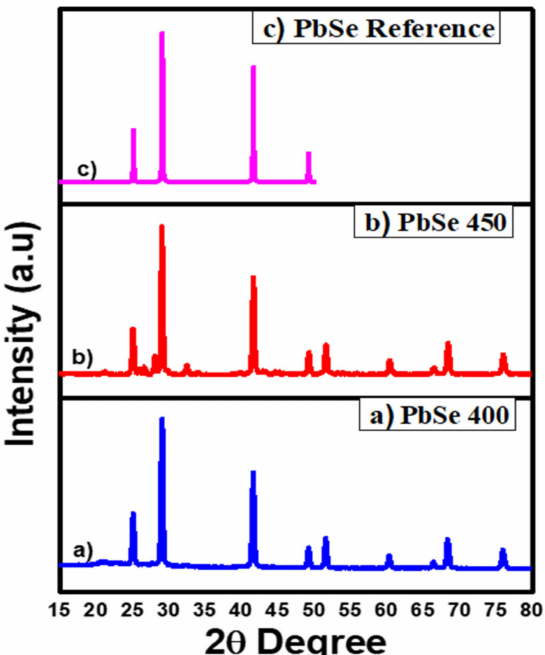
Figure 2. XRD pattern of PbSe prepared at ( a ) 400 ◦ C; ( b ) 450 ◦ C; ( c ) PBSe reference, reproduced or adapted from [47], with permission from Elsevier, 2021.